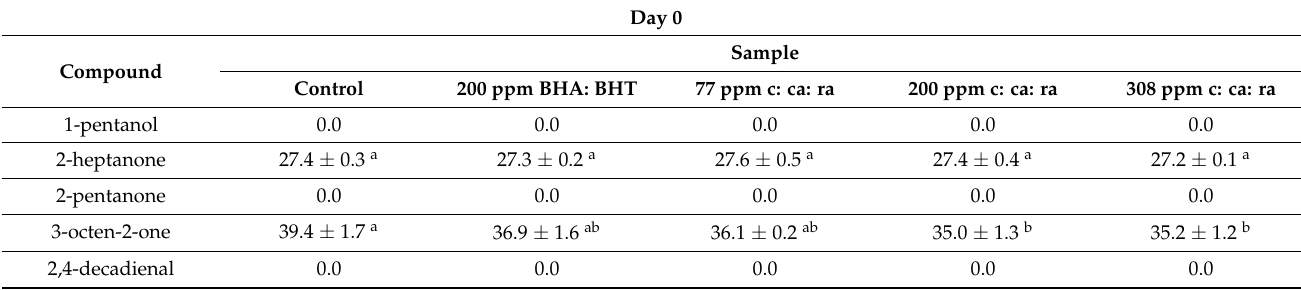
Table A4. Levels of volatile compounds ( µ g/kg of FFMP) as measured with HS-SPME-GC-MS analysis in FFMPs with or without antioxidants, before accelerated storage (40 ◦ C, RH 23%) 1, 2, 3, 4 . Day 0 Compound